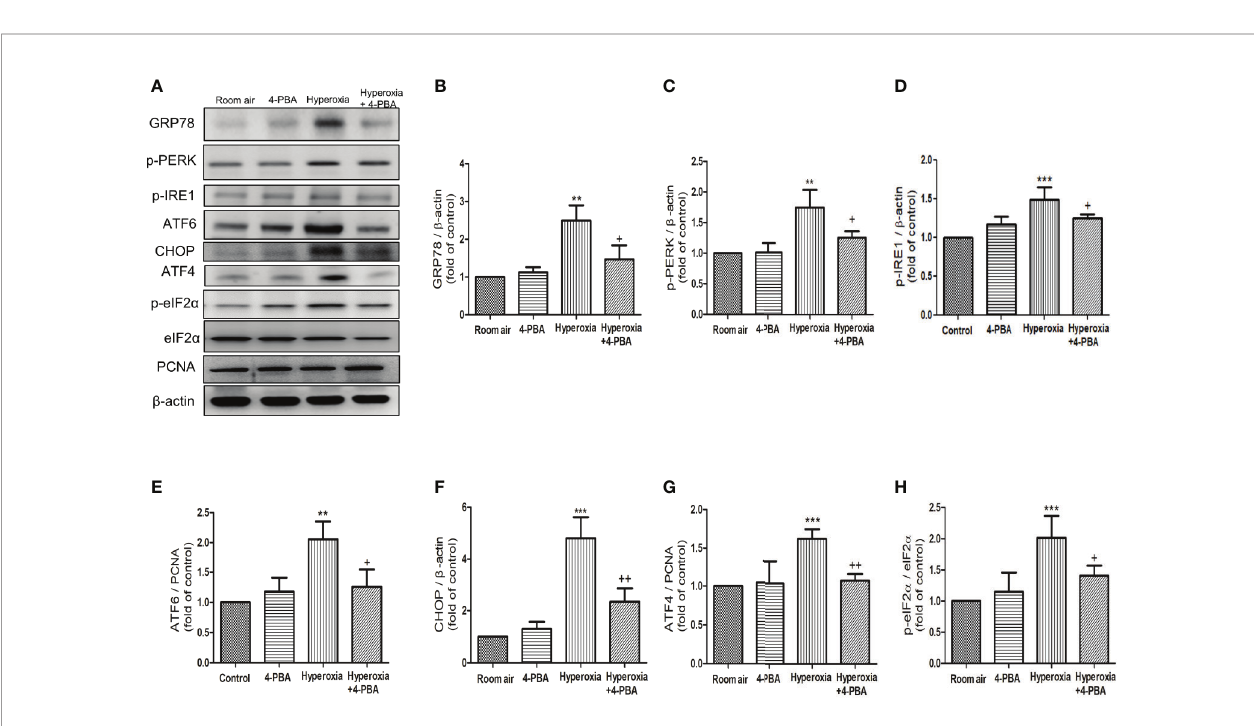
FIGURE 5 | 4-PBA alleviates hyperoxia-induced ER stress-related proteins in lung tissues. (A) Western blot analysis of GRP78, p-PERK, p-IRE1, ATF6, CHOP, ATF4, and p-elF-2 expression in lung tissues. Relative expressions of GRP78 (B) , p-PERK (C) , p-IRE1 (D) , ATF6 (E) , CHOP (F) , ATF4 (G) , and p-elF-2 (H) in lung tissues were shown. Data are expressed as mean ± SD (3 mice per group). **p < 0.01, ***p < 0.001, compared with the room air group; + p < 0.05, ++ p < 0.01 compared with the hyperoxia